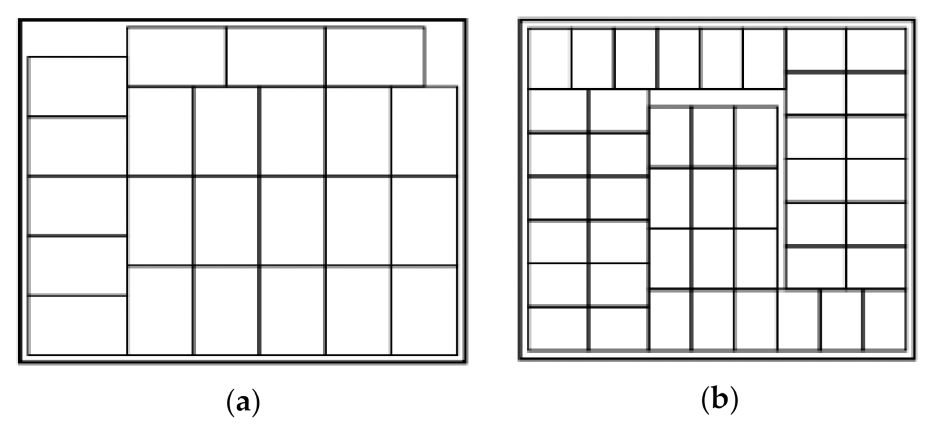
Figure 3. The three-block and five-block heuristics: ( a ) three-block heuristic and ( b ) five-block heuristic [36].